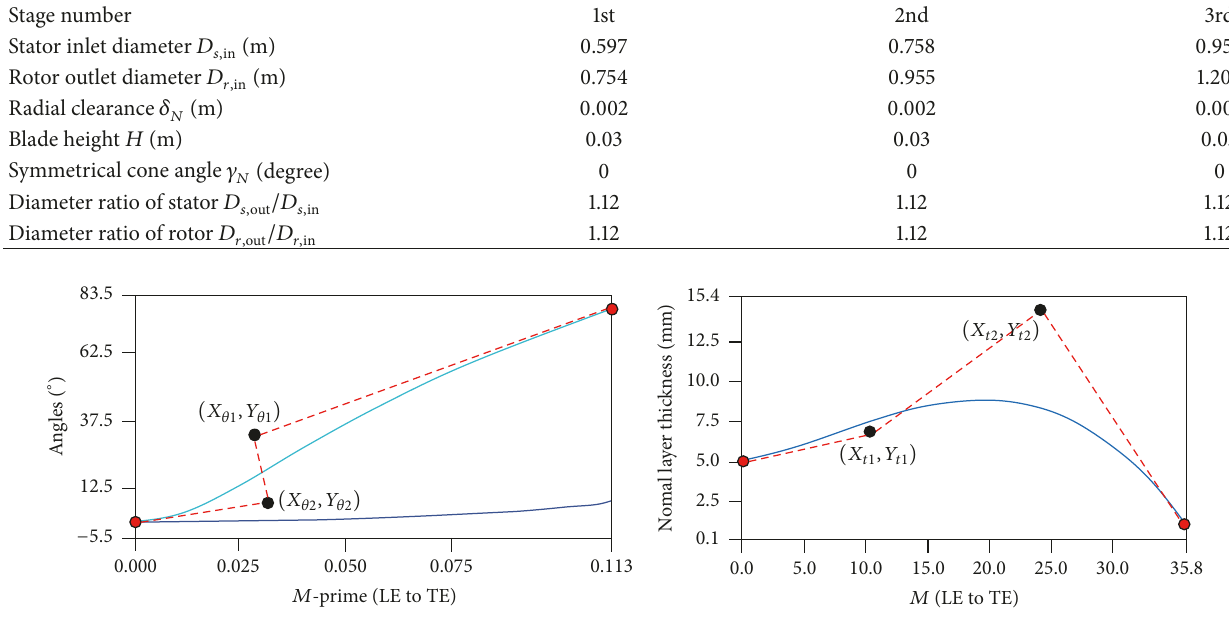
(b) The thickness distribution and control points selection of rotor